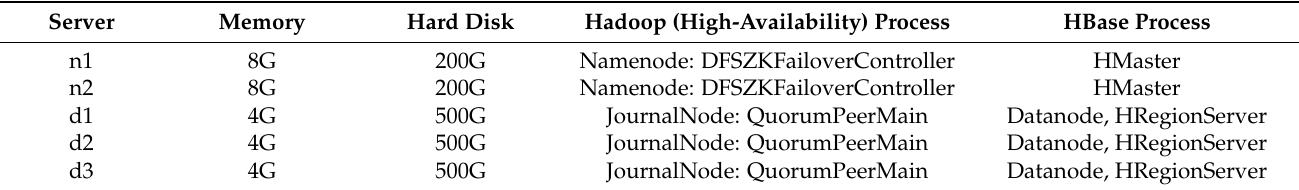
Table 1. Experimental hardware resource